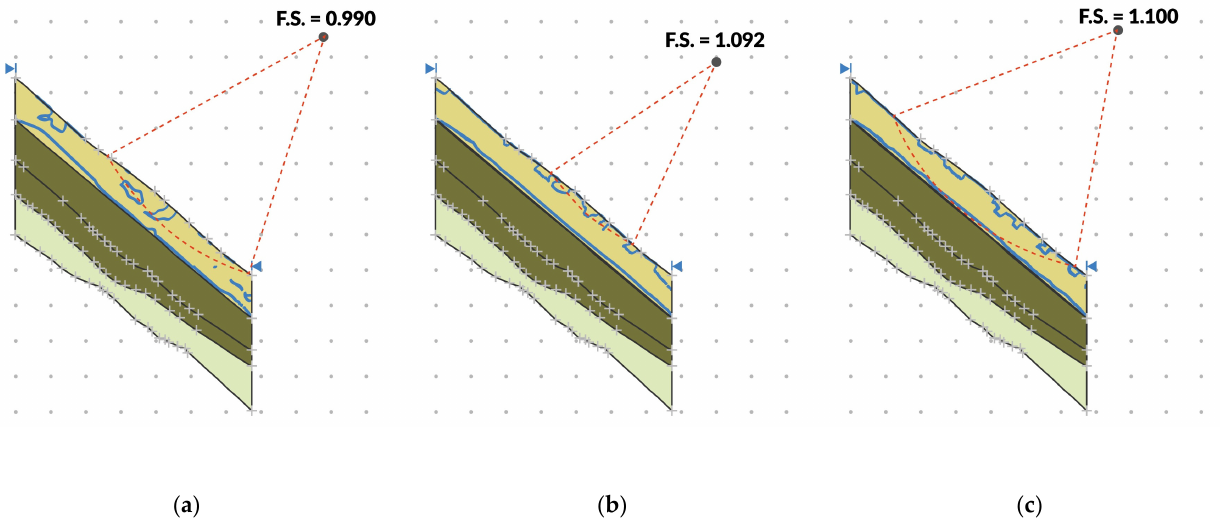
Figure 10. Factor of safety variation for different permeability coefficients. ( a ) k sat = 1.71 × 10 − 6 m/s, ( b ) k sat = 1.71 × 10 − 7 m/s (Basic Run), ( c ) k sat = 1.71 × 10 − 8 m/s.